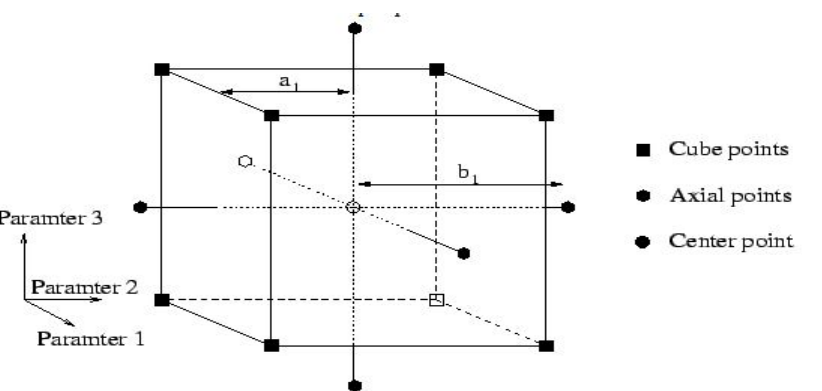
Figure 13. The example points of a Central Composite Circumscribed design with three input parameters [29].